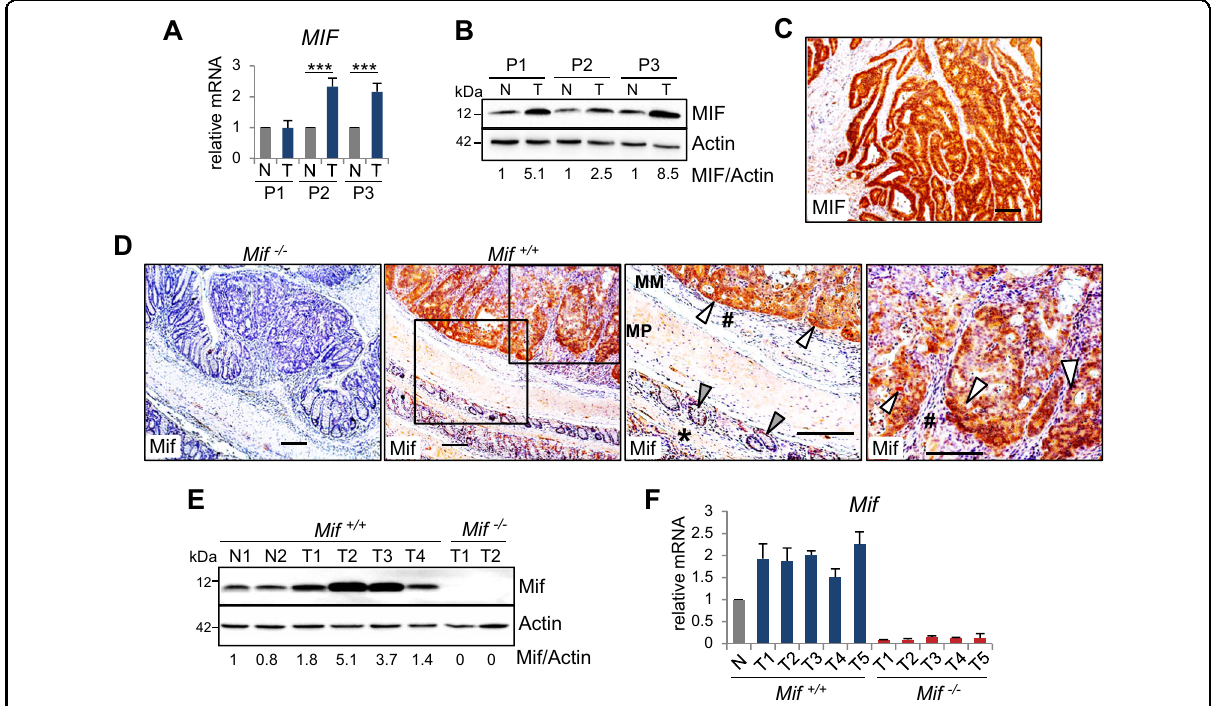
Fig. 2 MIF levels are elevated in CRC cells. A Relative MIF mRNA expression of individual human CRC patients (P1 – P3). Matched pairs of adjacent epithelia ( ‘ N ’ ) and their tumors ( ‘ T ’ ) were evaluated by qRT-PCR, and RNA levels were normalized to those of RPLP0 mRNA. Mean ± SD of four technical replicates. Student ’ s t test was performed for comparison of indicated groups; *** p ≤ 0.001. B MIF protein levels in matched pairs of tumor ( ‘ T ’ ) and adjacent epithelial ( ‘ N ’ ) tissues from three individual human CRC patients (P1 – P3). Immunoblot analysis. Actin, loading control. MIF expression ratios (MIF/Actin) were calculated by densitometry, normalized to the loading control, relative to the respective epithelium ( ‘ N ’ ). C Histological MIF staining in a colonic tumor from a human CRC patient. Scale bar, 200 µm. D Representative histological Mif staining in colonic tumors from Mif + / + and Mif − / − mice. Mif − / − tumors served as negative control. Rectangles represent the area at a higher magni fi cation. MM, muscularis mucosae; MP, muscularis propria. White arrows, tumor epithelial cells with elevated MIF levels. #, stromal cells of mucosae. Gray arrows, epithelial cells within the next surrounding colonic tissue layer. *, MM and MP of the next surrounding layer. Note that normal epithelial cells from untransformed regions of the colon show low MIF levels (gray arrow) compared to those in tumor cells (white arrow). Scale bars, 200 µm. E Mif protein levels in murine single tumor samples ( ‘ T ’ ) compared to matched normal epithelium ( ‘ N ’ ) from Mif + / + mice. Mif − / − tumors served as a negative staining control. Mif ratios were calculated as described in ( B ). F Mif mRNA level in single tumor samples ( ‘ T ’ ) of Mif + / + and Mif − / − mice compared to pooled normal epithelium ( ‘ N ’ ) of Mif + / + mice ( n = 2). mRNA levels were normalized to those of Rplp0 mRNA. Means ± SD of four technical